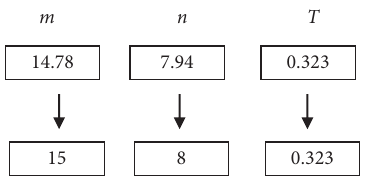
Figure 5: Illustration of decision variable